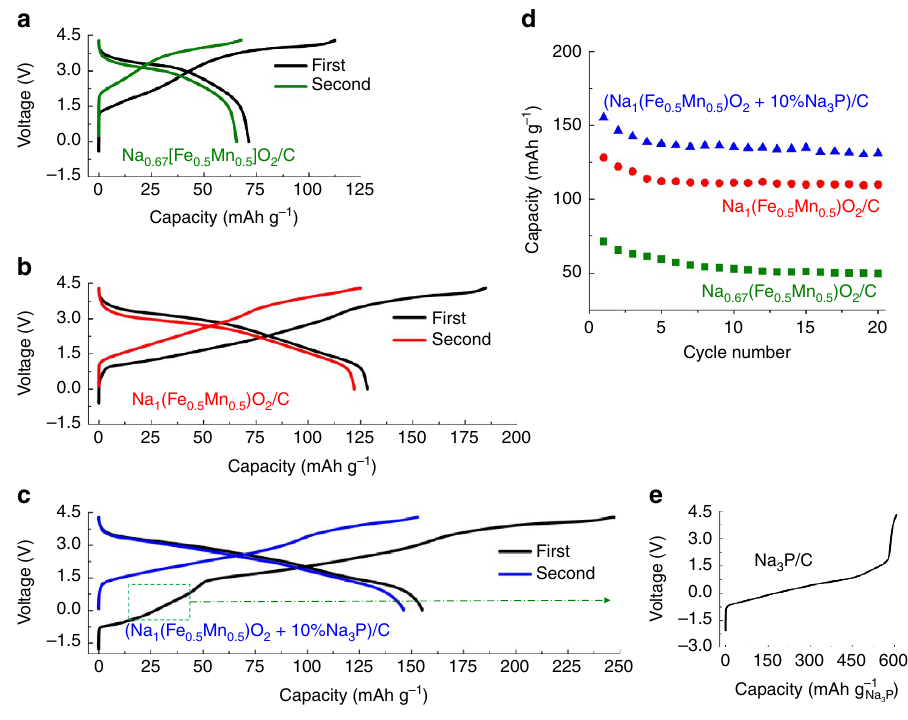
Figure 7 | Performances of C/P2-Na 0.67 [Fe 0.5 Mn 0.5 ]O 2 Na-ion cells. The voltage-composition profiles are reported for the two first cycles for cells using ( a ) as-made P2-Na 0.67 [Fe 0.5 Mn 0.5 ]O 2 (cell D1), ( b ) P 0 2-Na 1 [Fe 0.5 Mn 0.5 ]O 2 made by Na ball milling (cell D2) and ( c ) for a P 0 2-Na 1 [Fe 0.5 Mn 0.5 ]O 2 /Na 3 P composite (cell D3) as positive electrode. The negative electrode is C. The weight ratio of positive to negative electrode is 2.6, 1.6 and 1.4 for D1, D2 and D3 cell, respectively. The cells were cycled at 0.1C rate. The capacity is based on the weight of positive materials, including Na 3 P for D3 cell. The capacity retention of D1, D2 and D3 cell is given ( d ), and e shows the first charge profile of a C/Na 3 P cell. For all cells a 1M NaClO 4 in EC/DMC (50/50 by volume) electrolyte was